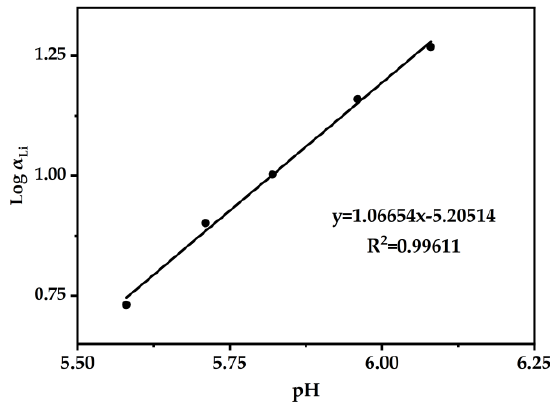
Figure 9. Linear graphs of Log α Li versus pH were plotted. The DES extractant (molar ratio: HTTA/TOPO = 2/1) was used, and the initial concentration of Li + was 25 ppm. Aqueous phase: organic phase = 4:1.